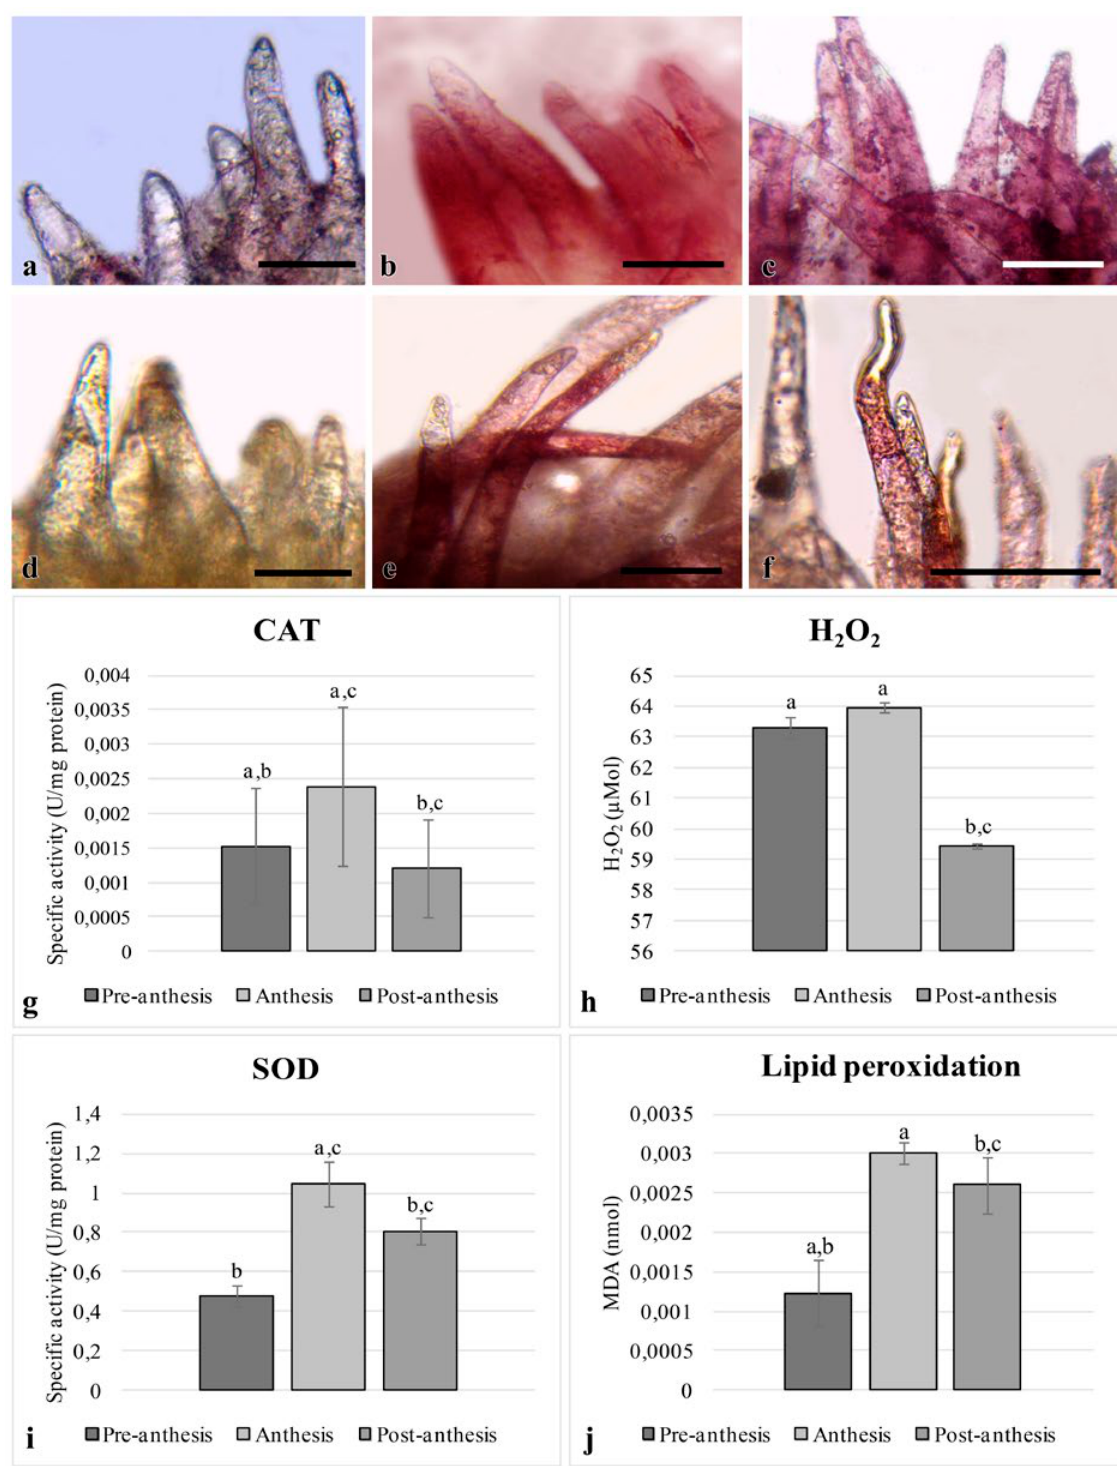
Figure 5. Enzymatic activities in stigma of Hibiscus syriacus . Non spesific esterase activity at pre-anthesis (a), anthesis (b), post-anthesis (c). Peroxidase activity at pre-anthesis (d), anthesis (e), post-anthesis (f), CAT activity (g), SOD activity (h), H 2 O 2 content (i) and lipid peroxi- dation (j) of stigmas at different developmental stages. The data with different letters are significantly different according to Tukey’s test at P < 0.05 for independent samples. Results are expressed as mean ± SD. Scale: 50